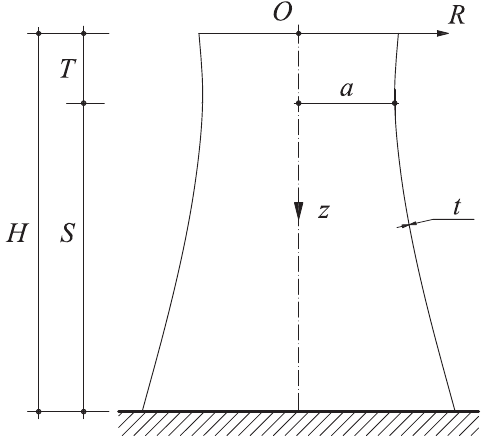
Figure 11. Hyperboloid of revolution under wind load. Cross